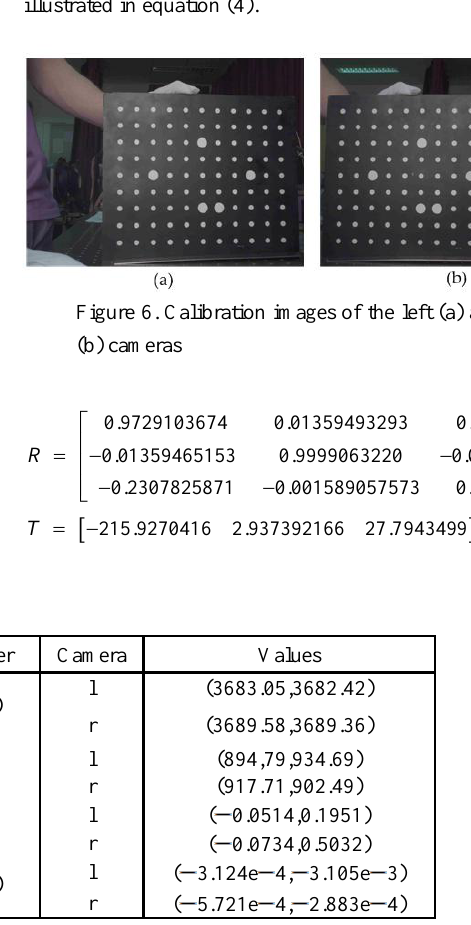
Figure 4. Photograph of the prototype